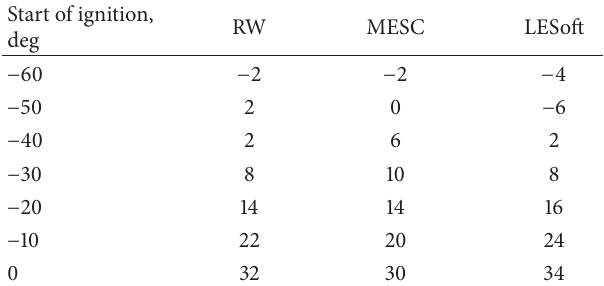
Table 6: Location of pressure peak predicted with various packages.